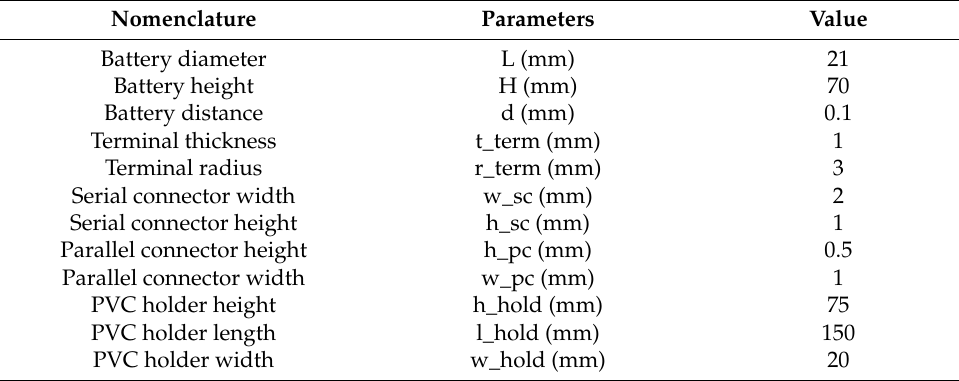
Figure 2. Scheme of the battery pack. The geometric parameters of the simulated battery and the PVC holder of the battery pack are given in Table 1, while their physical parameters are listed in Table 2, which are based on the experimental data reported in the literature. Table 1. Geometric parameters were used in the simulation.